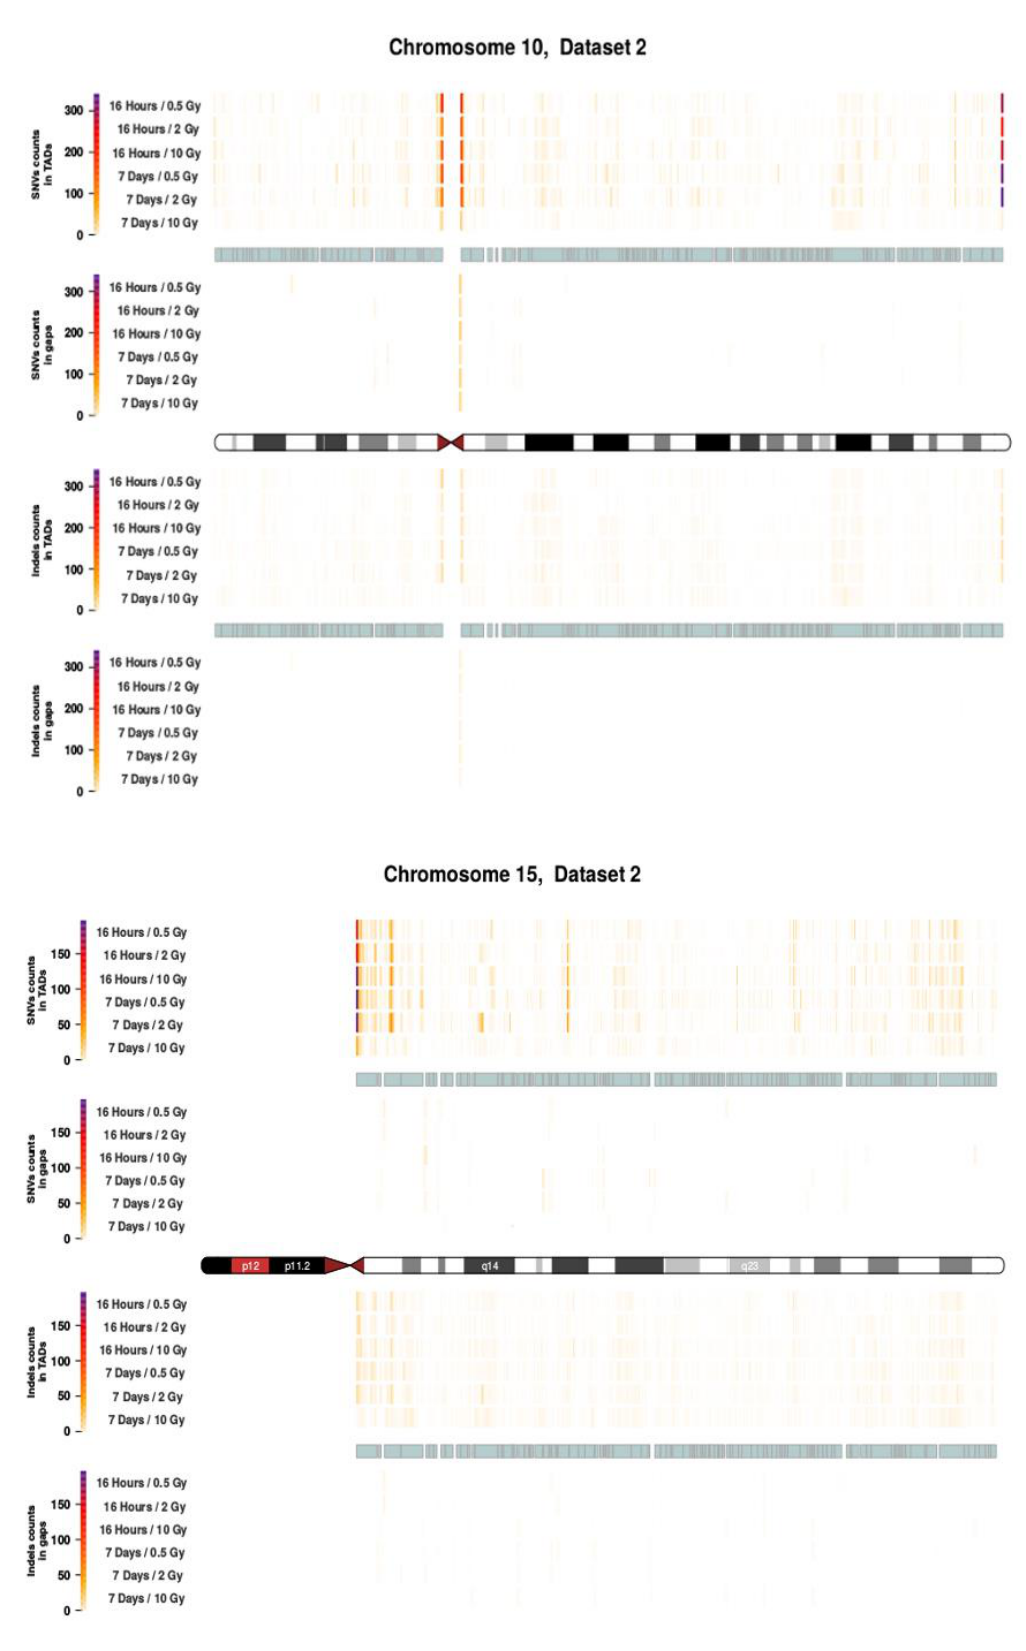
Figure A5. Topological association domains (TADs) plot shows the distribution of SNVs (above panel) and InDels (below panel) counts over within and outside TAD coordinates for Chroosome 10 and 15 in dataset 2.